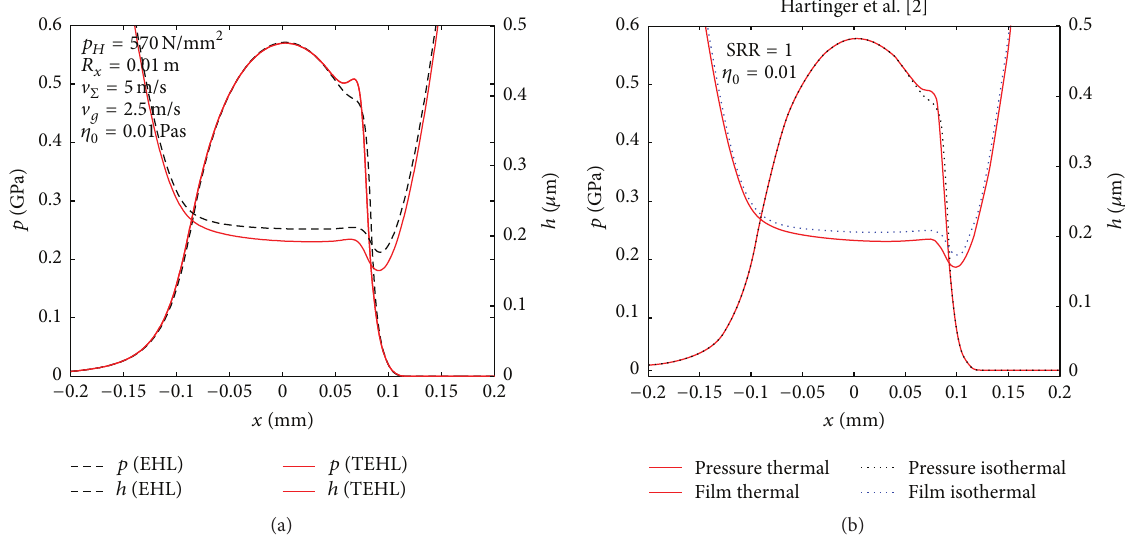
Figure 4: Comparison of simulated pressure and film thickness distributions for a thermal (TEHL) and an isothermal (EHL) contact between the TEHL simulation model of this study (a) and the CFD model of Hartinger et al. [2] (b).